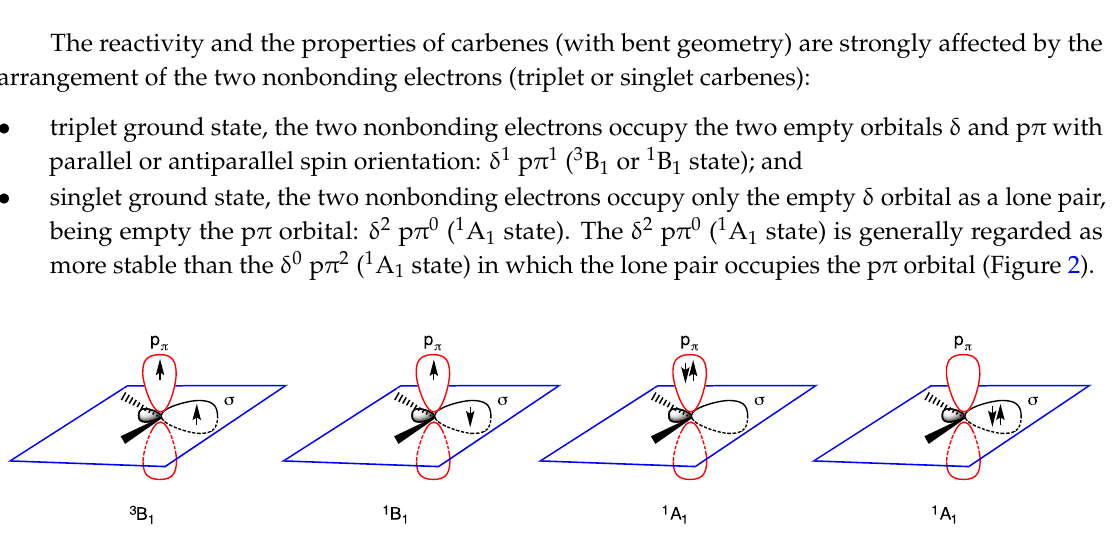
Figure 1. Geometry at the carbene carbon atom: linear and bent. Arrows: electrons.